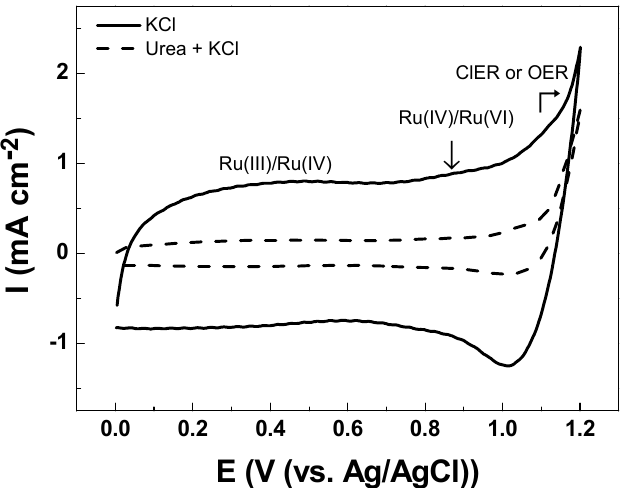
Figure 4. Cyclic voltammetry registered in 0.10 mol L -1 KCl solution ( - ) in the absence of urea, and ( --- ) in the presence of 3.33 × 10 − 4 mol L − 1 of urea Ti/RuO 2 -TiO 2 -SnO 2 (50:40:10 atom. %) as the ( --- ) in the presence of 3.33 × 10 -4 mol L -1 of urea Ti/RuO 2 -TiO 2 -SnO 2 (50:40:10 atom. %) as the working electrode at υ = 50 mVs − 1 scan rate at pH 5.3 ± 0.1 and T = 24 ◦ C. working electrode at υ = 50 mVs -1 scan rate at pH 5.3 ± 0.1 and T = 24 °C.